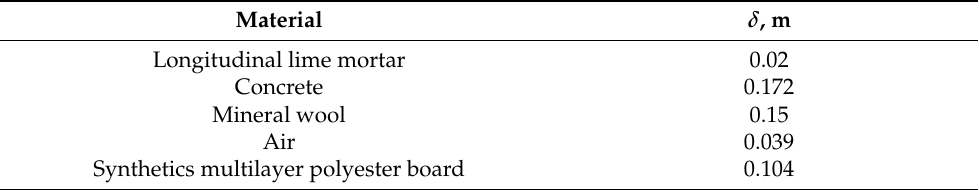
Table 4. External wall of the ventilated façade with the optimal layer